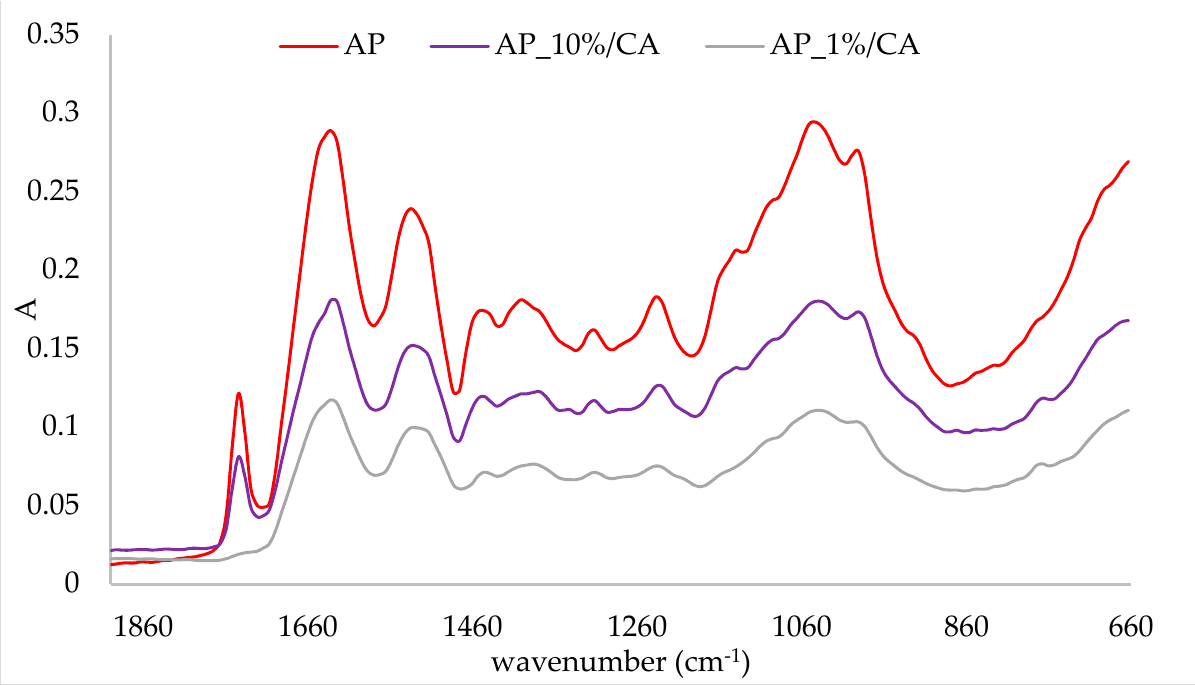
Figure 2. IR spectra of almond protein (AP) and obtained complexes with cinnamic acid (AP_10%CA—complex prepared with 10% of protein matrix; AP_1%CA—complex prepared with 1% of protein matrix).